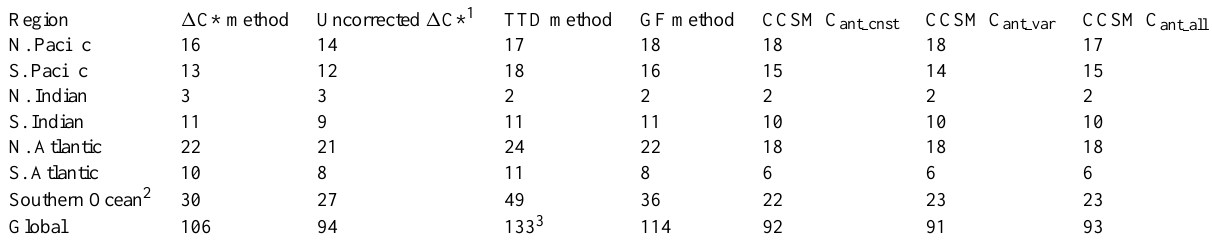
Table 2. Regional and global distributions of C ant inventories in 1994 (in PgC)